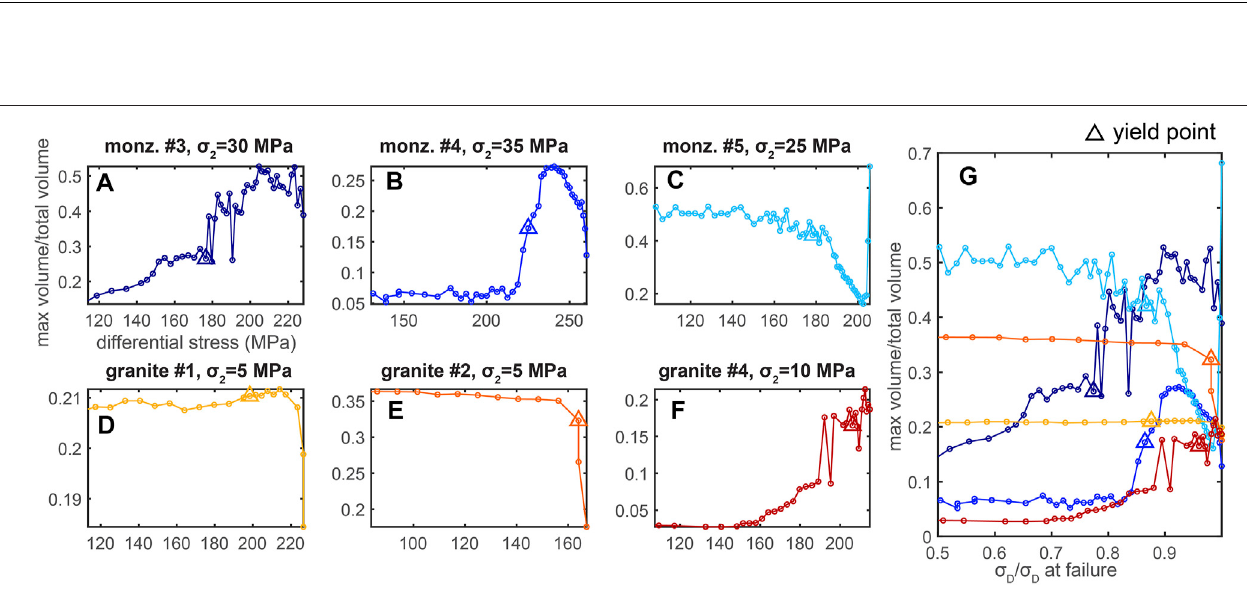
Frontiers in Earth Science |